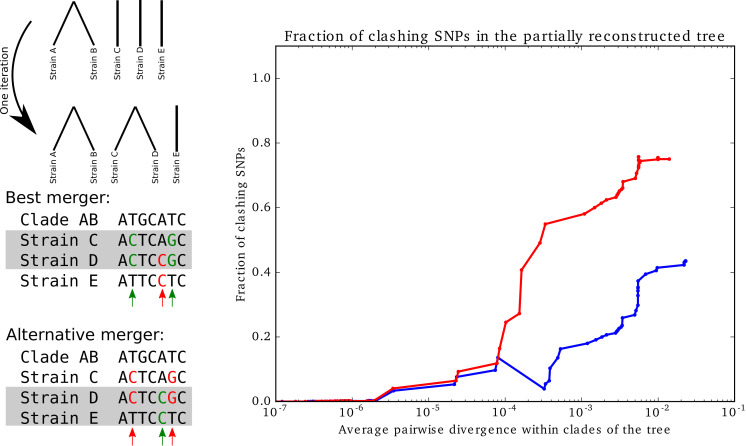
Supporting versus clashing SNPs for trees that were built bottom-up, while minimizing SNP clashes. Left panel: Illustration of the iterative bottom-up tree reconstruction. At each step, the pair of clades is fused that minimizes the number of SNPs that clash with the fusion (red arrows). In case of multiple pairs that have the same number of clashing SNPs, the pair with the largest number of supporting SNPs (green arrows) is chosen. Right panel: Fraction of SNPs that support vs. clash with the partially reconstructed tree as a function of the average pairwise divergence of strains that occur within the clades of the partially reconstructed tree. The blue curve corresponds to the full set of strains and the red curve to all strains except for the outgroup. The horizontal axis is shown on a logarithmic scale.